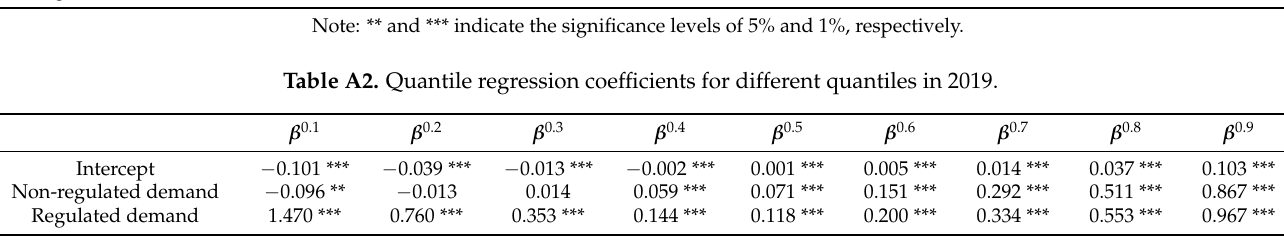
Table A2. Quantile regression coefficients for different quantiles in 2019.